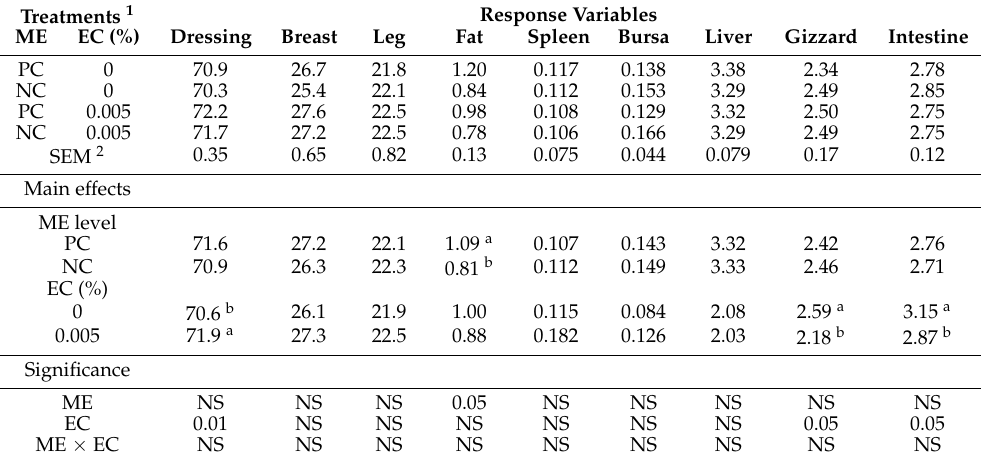
Table 4. Effect of dietary metabolizable energy (ME) level, enzyme cocktail (EC) supplementation, and their interaction on broiler processing variables (%, based on preslaughter weights) at 35 days. Treatments 1